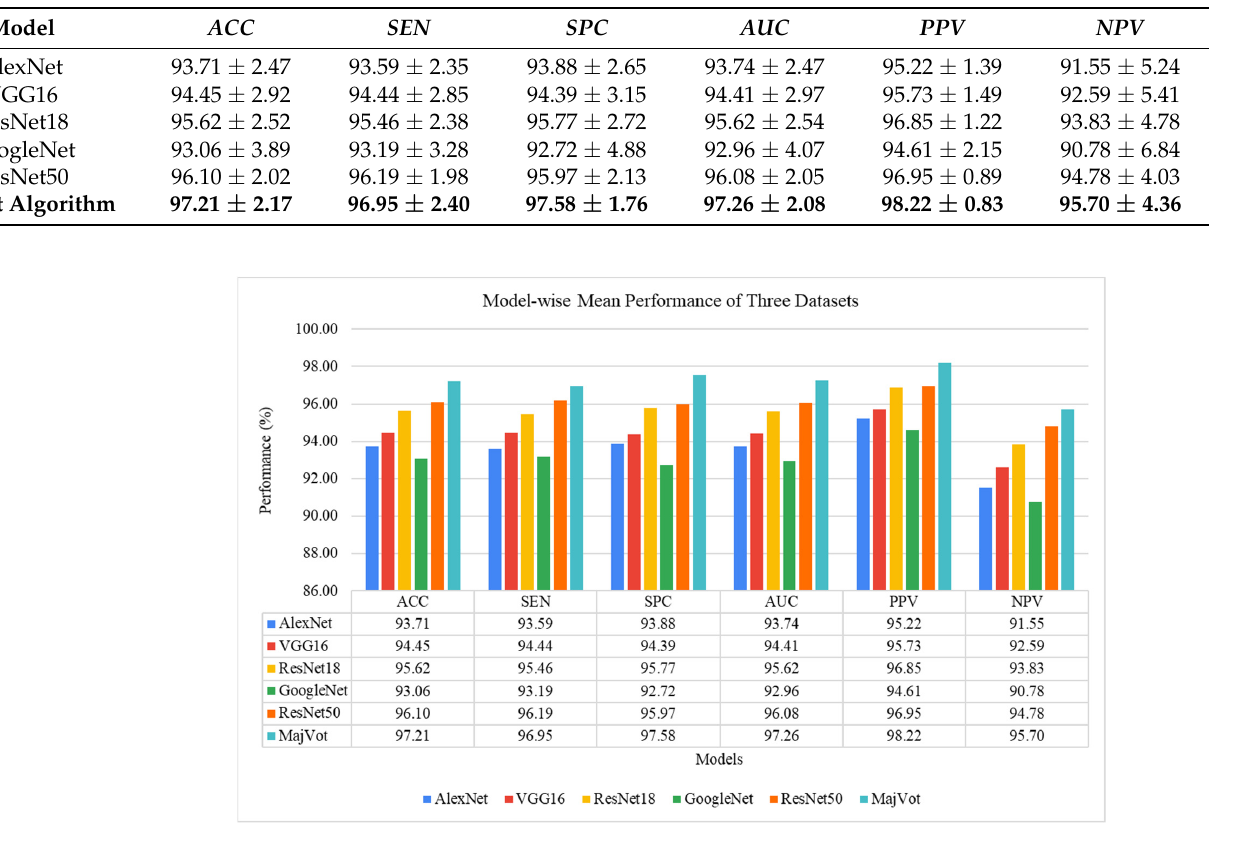
Figure 16. The model-wise average performance of three datasets.